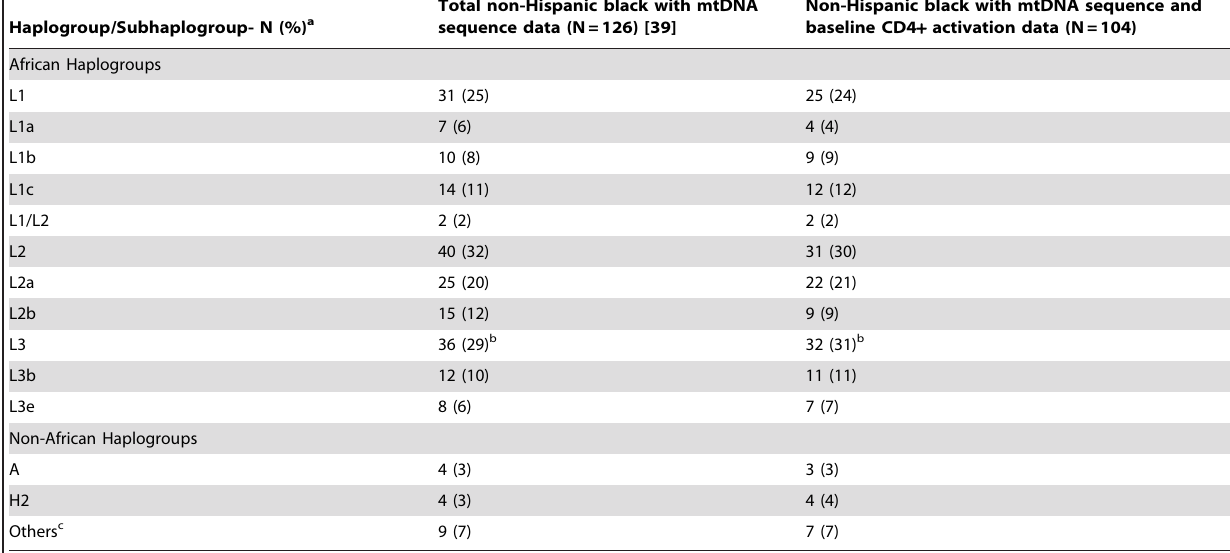
Haplogroup/Subhaplogroup- N (%) a